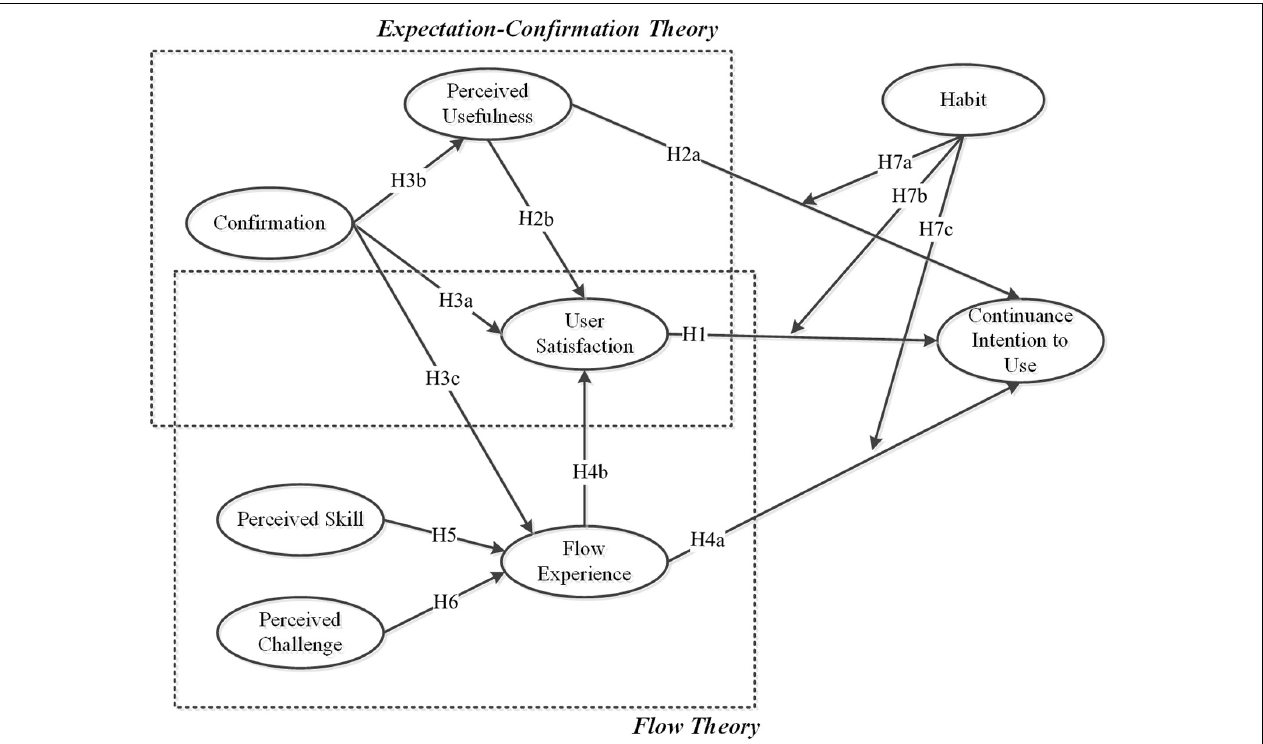
FIGURE 1 | Research